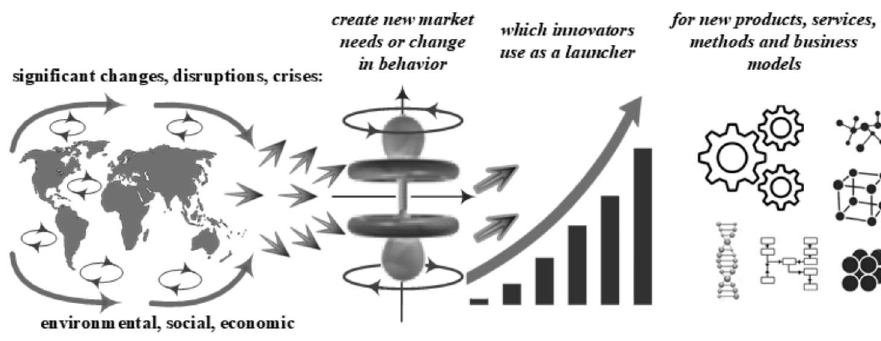
Figure 1. Historical pattern for creating crisis innovations